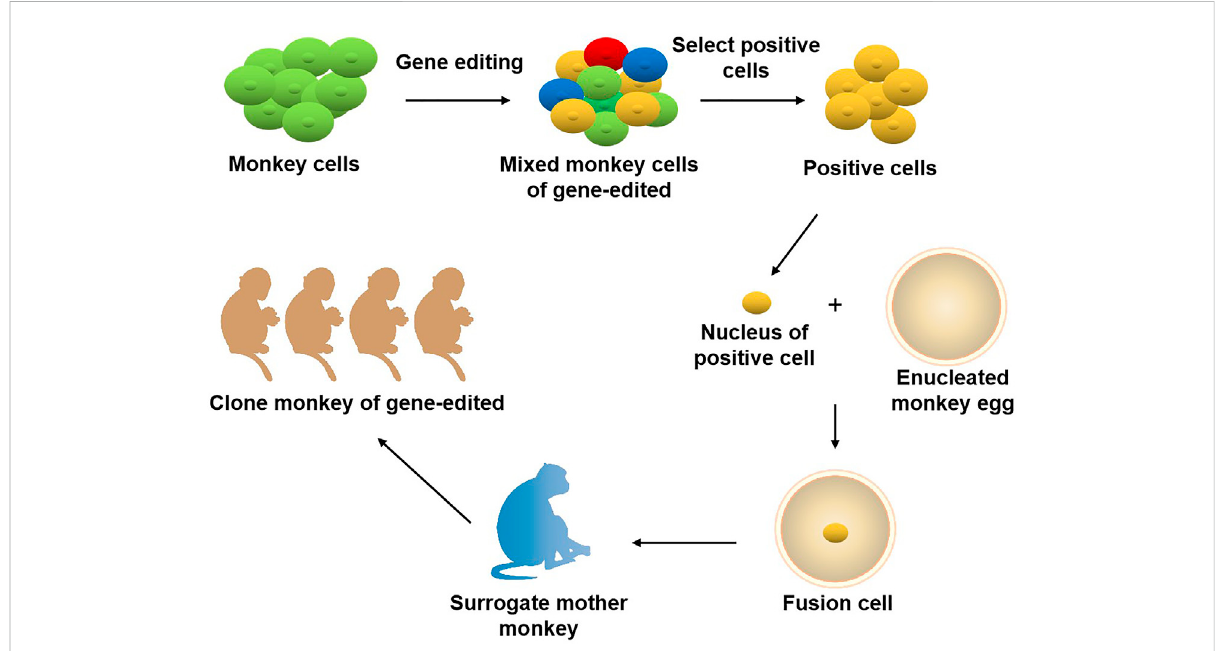
FIGURE 2 Joint application of gene editing and nuclear transfer technique in producing gene-modi fi ed monkeys. Using gene editing technology to modify the genome of monkey cells, and screen out speci fi c types of positive cells. The nuclei of the positive cells are transferred to the enucleated monkey eggs, and the fusion cells are transferred to the surrogate mother monkey to obtain the gene-edited cloned monkeys.